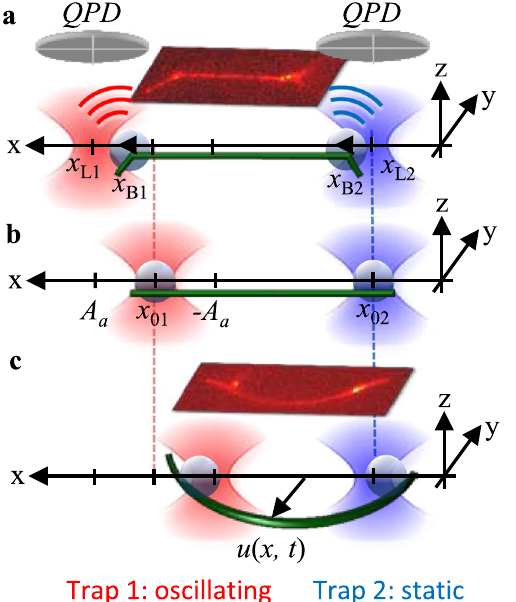
Figure 1. Design of experiment illustrating different stages of an oscillation period. Optically trapped d = 1.06 µ m Neutravidin-coated beads are used as anchors points for laterally attached, biotinylated microtubules. Bead positions are tracked interferometrically by QPDs. ( a ) The filament is stretched during the first half oscillation period. ( b ) The filament is straight after each half period. ( c ) The filament is buckled during the second half oscillation period. Insets: overlay of corresponding fluorescence and brightfield